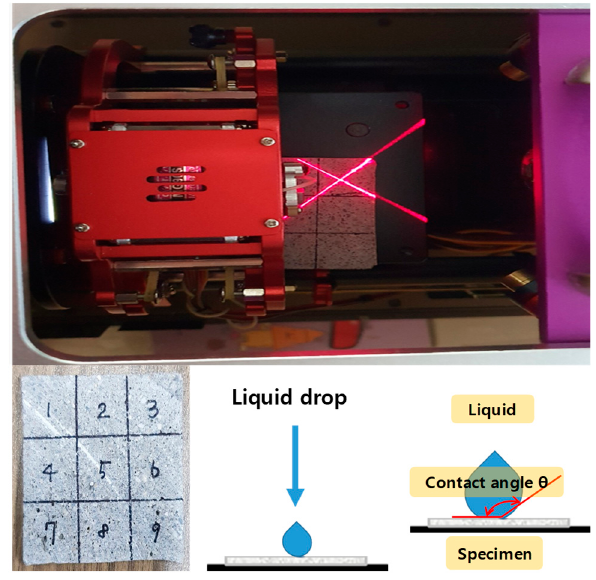
Figure 3. Measurement of contact angle.